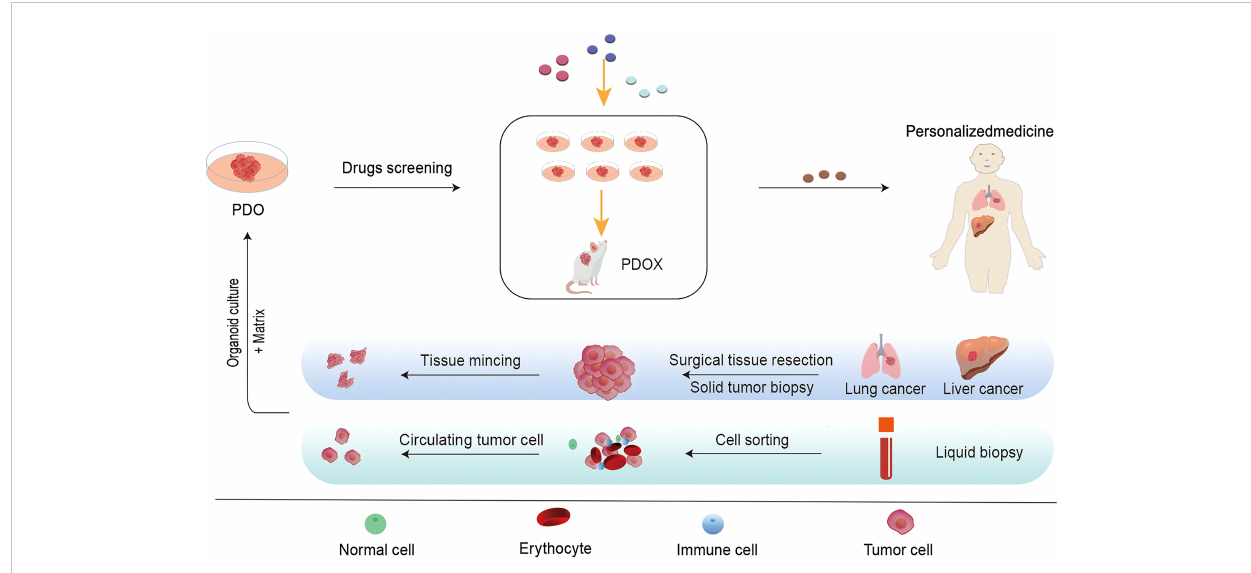
FIGURE 2 The fl ow chart of the establishment of patient-derived tumor organoid (PDO) models and the application of PDO in personalized treatment. It is commonly used to obtain primary tumor samples from surgical resections, puncture samples, or circulating tumor cells (CTCs) isolated from blood samples. Patient-derived cancer cells can be propagated in vitro on an enriched Matrigel matrix and cultured into three-dimensional tumor-like organs for in vitro and in vivo applications. These tumor models can be used for drug screening, gene analysis, immunotherapy, and other studies to accurately detect drug ef fi cacy and toxicity. Furthermore, we are able to develop effective individualized treatment strategies for